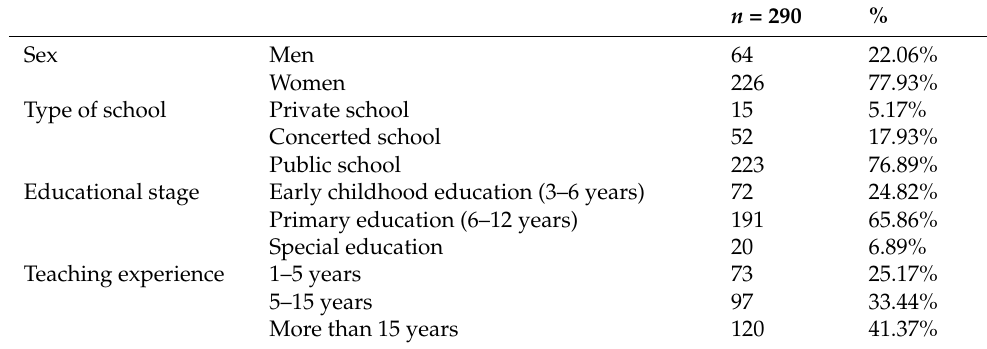
Table 1. Characteristics of